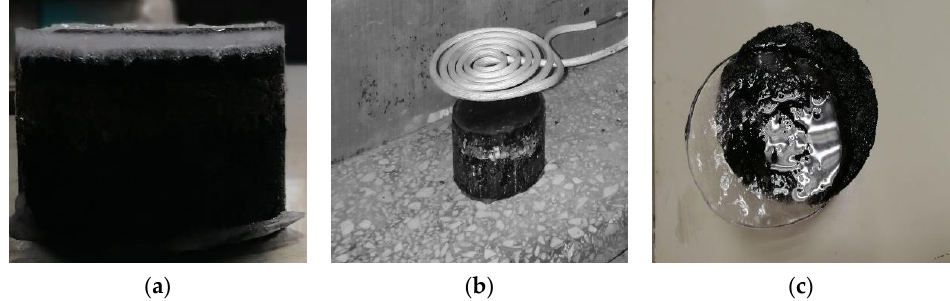
Figure 9. Experimental process. ( a ) Prepared specimen; ( b ) Specimen of heating; ( c ) Specimen after heating.